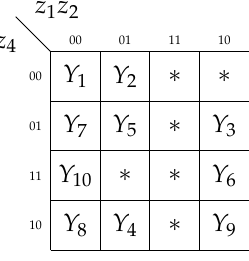
Figure 6. Codes of COs of Mealy FSM U 4 ( S 1 )